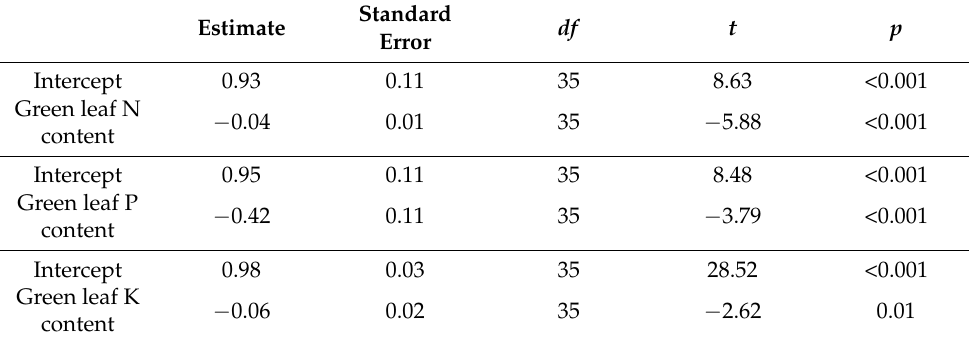
Figure 2. Relationships between nutrient resorption efficiencies and green leaf nutrient contents under mild ( a , c , e ) and severe ( b , d , f ) disturbances in the Phoebe bournei forest. N: nitrogen, P: phosphorus, K: potassium. The shaded area represents the 95% confidence interval of the regression line. Table 2. Linear regression models between green leaf N and NRE, P and PRE, and K and KRE in the Phoebe bournei forest. Results are the estimated regression parameters, standard errors, and t and p for the linear regression models.